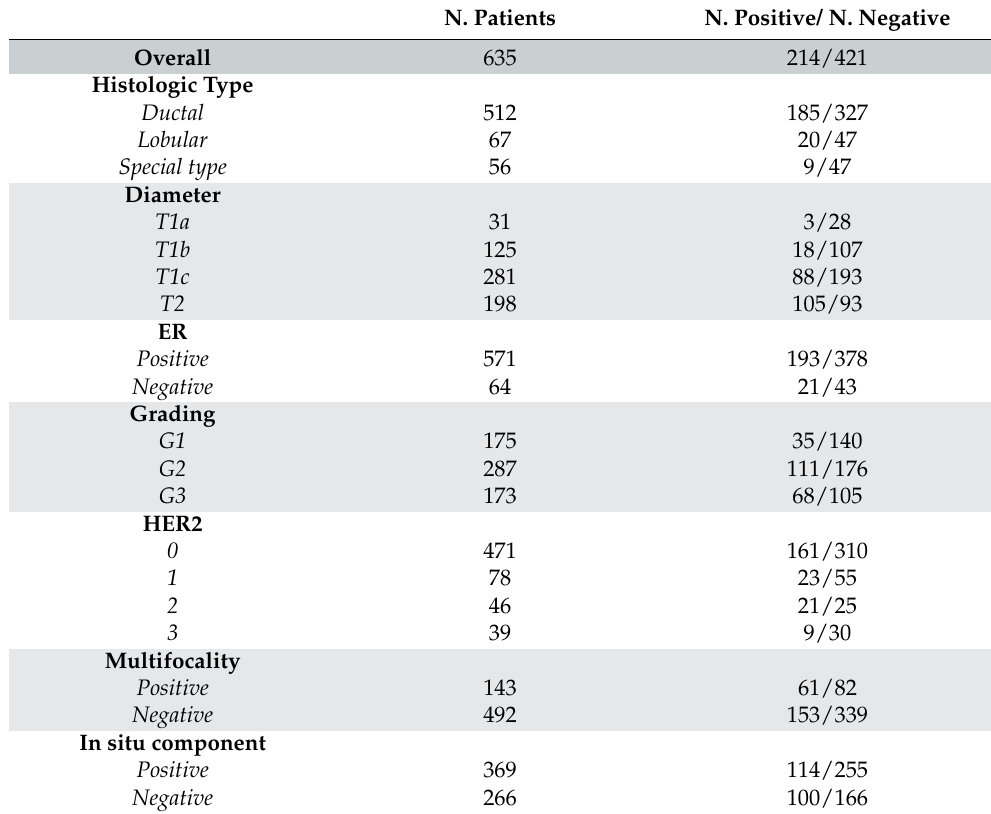
Table 1. Characteristics of the samples collected in this study.